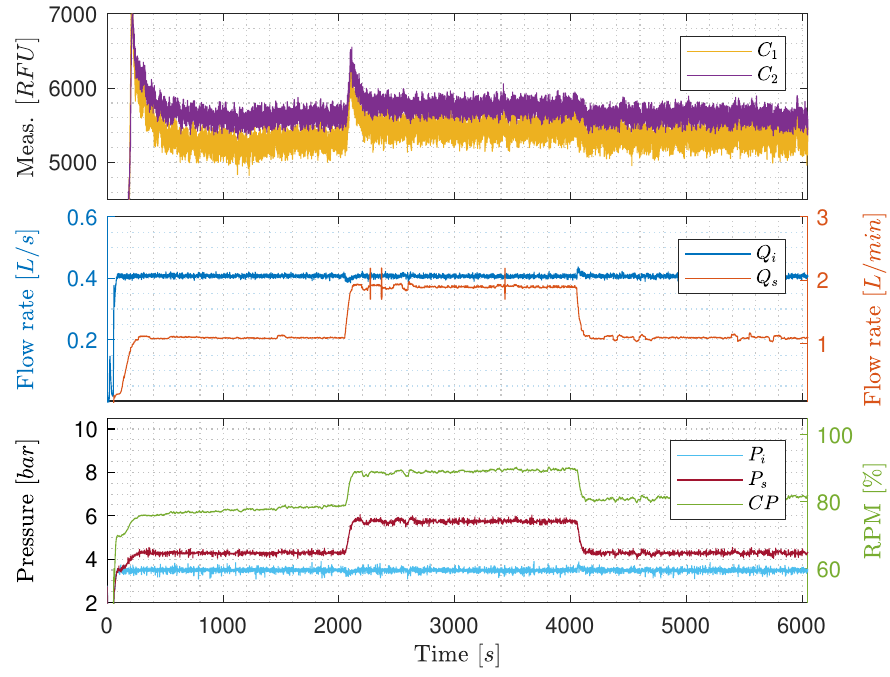
Figure 8. Constant Q i with varying Q s